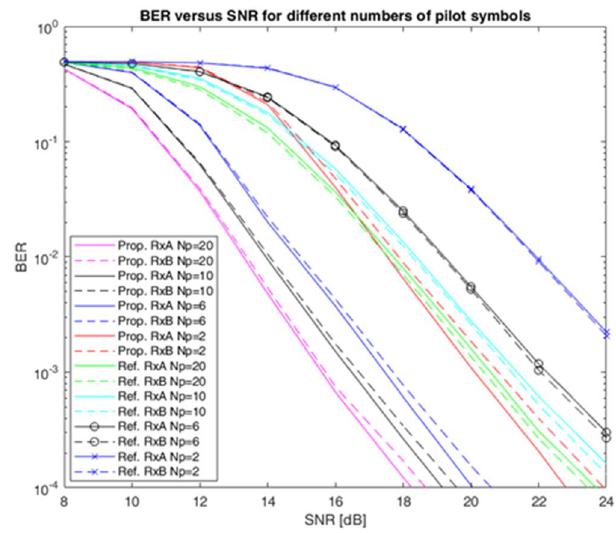
Figure 8. BER for the end terminal for the proposed and reference PNC algorithms applied in the relay depending on the number of OFDM pilot symbols N p .